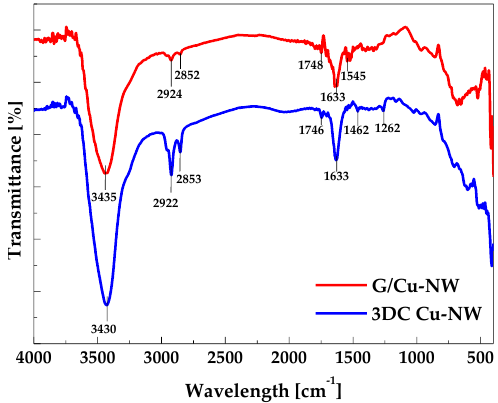
Figure 6. FT-IR spectra of G / Cu-NW and 3DC Cu-NW.